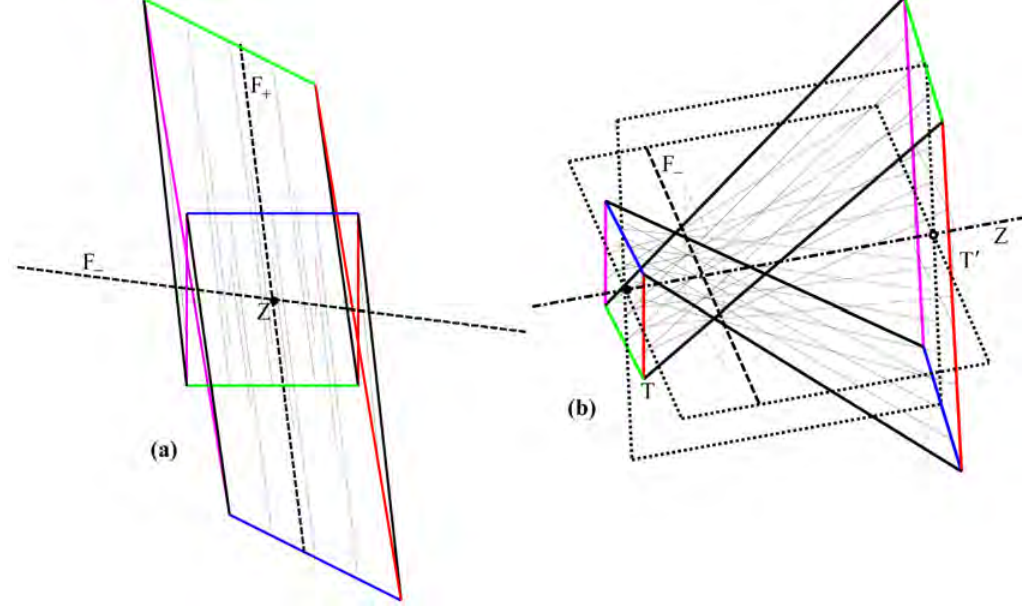
Figure 16 A pencil with divergency JIM +−= D at T. The divergency is singular. Its (horizontal) line focus is shown. One can regard the other (vertical) line focus as at infinity. (b) azimuth °− 20 17 °− 20 , elevation 36 °− 20 .